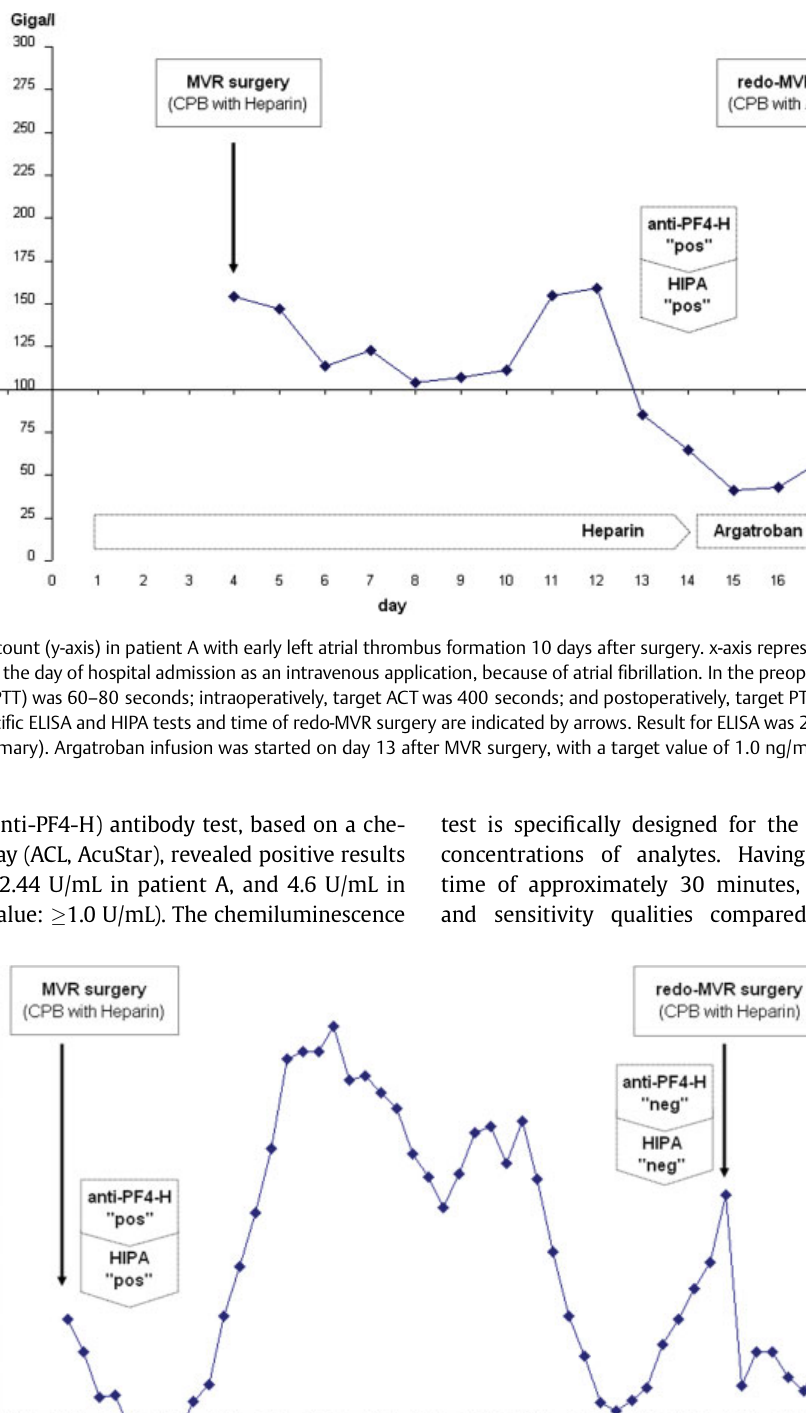
Fig. 2 Thrombocyte count (y-axis) in patient B with delayed left atrial thrombus formation 5 weeks after surgery. x-axis represents timeline. Unfractioned heparin was started on the day of hospital admission as an intravenous application, because of atrial fi brillation. In the preoperative period, target PTTwas 60 – 80 seconds; intraoperatively, target ACTwas 400 seconds; and postoperatively, target PTTwas again 60 – 80 seconds. Time of PF4-H IgG-speci fi c ELISA and HIPA tests and time of redo-MVR surgery are indicated by arrows. Result for ELISA was 2.04 OD, for HIPA 4